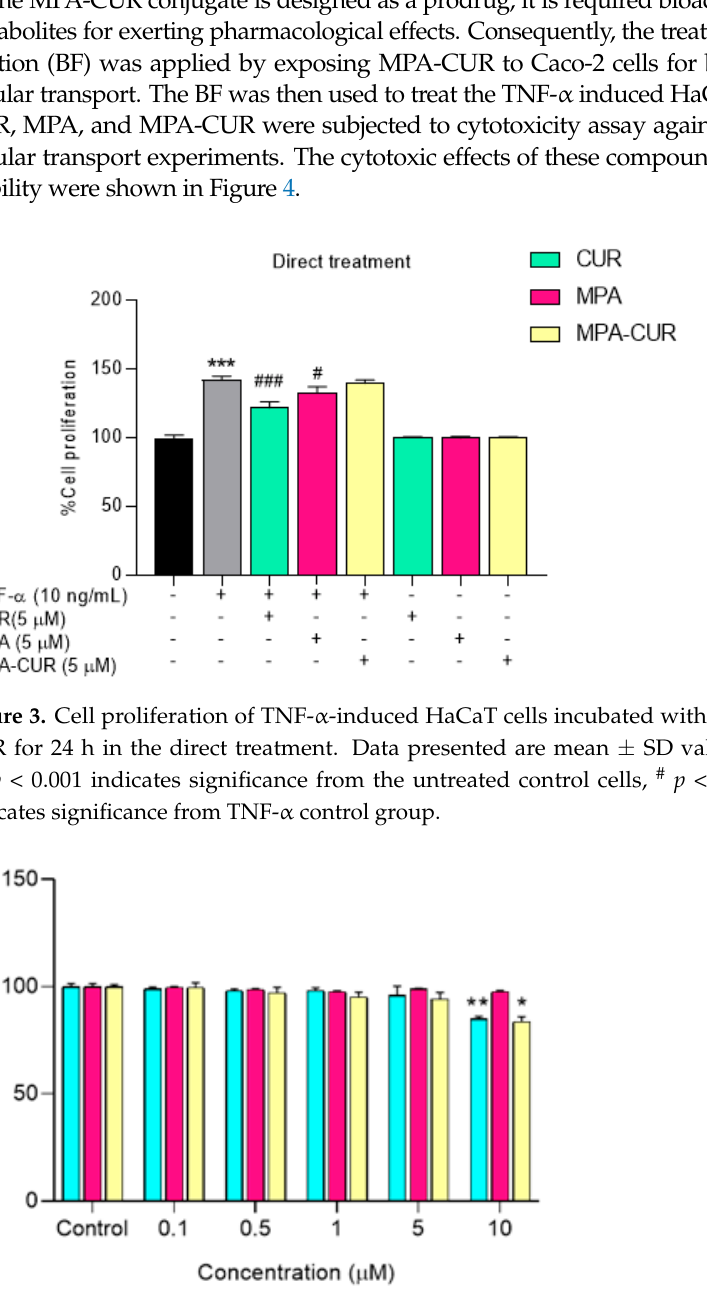
Figure 4. Cell viability of Caco-2 cells incubated with CUR, MPA, and MPA-CUR over a concen- tration range of 0.1–10 µM for 24 h. Data presented are mean ± SD values of four replicates * p < 0.05 and ** p < 0.01 indicates significance from the control group.